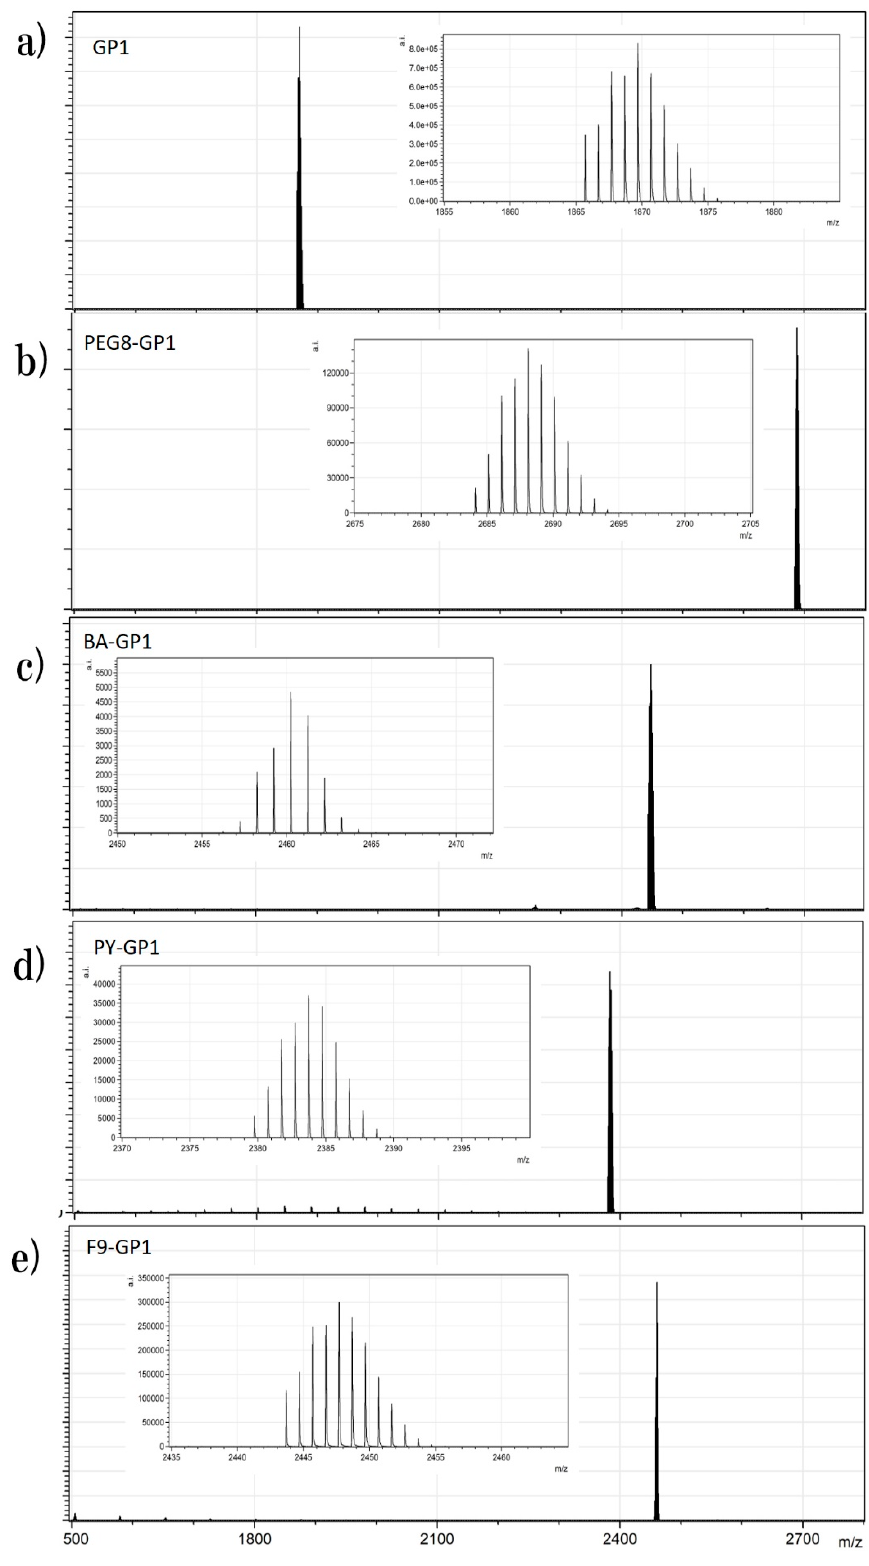
Figure 11. MALDI-TOF MS spectra of ( a ) GP 1 , ( b ) PEG8-GP 1 , ( c ) PY-GP1 , ( d ) BA-GP1 , and ( e ) F9GP-1 on JSM-S3000 (JEOL) with spiral mode. Matrix: DCTB, [M + Na] + species were observed. Insets: their expanded spectra.